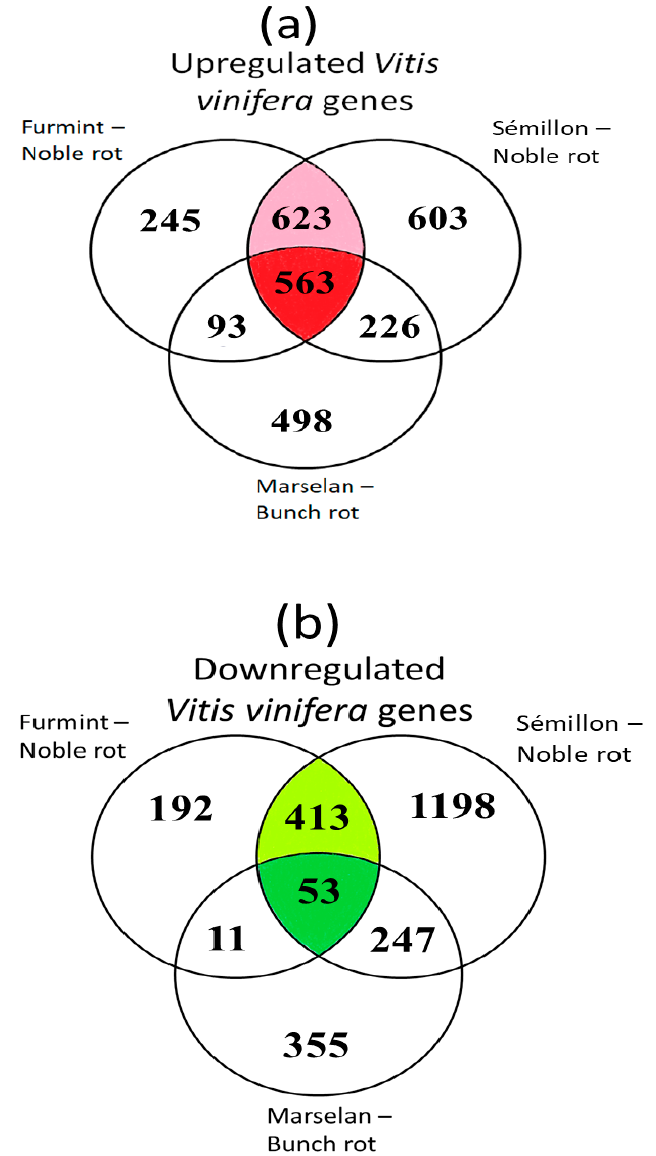
Figure 3. Venn diagrams show the overlap of differentially expressed genes (DEGs) during noble rot in Furmint and Sémillon and bunch rot in Marselan. Stage I. natural Furmint noble rot samples analyzed in this study were compared to stage II. natural Sémillon noble rot samples [7] and Marselan berries [2] that were collected 48 h after artificial inoculation with B. cinerea . ( a ) Upregulated DEGs in botrytized vs. healthy samples. ( b ) Downregulated DEGs. These results suggest that Furmint and Sémillon samples (both exposed to noble rot-